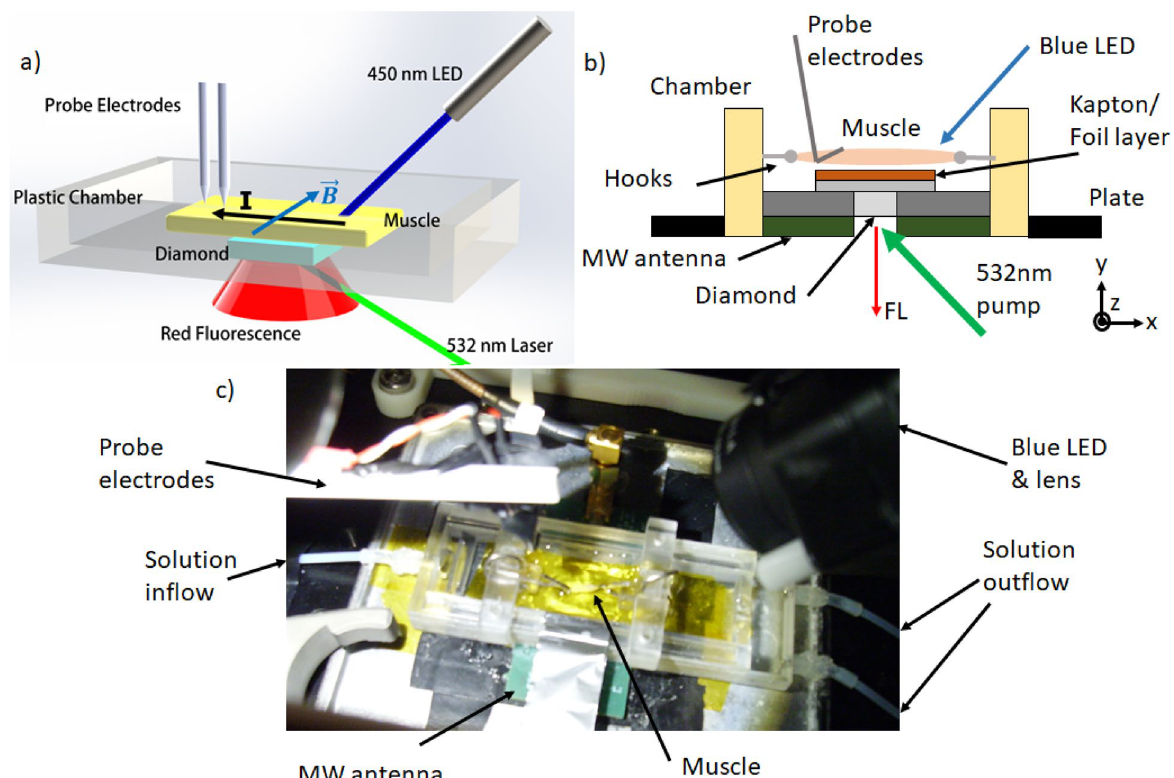
Figure 1. Experiment schematic and photograph. ( a ) Simplified 3D schematic of the magnetometer setup, showing the laser and blue LED illumination and fluorescence (FL) collection directions and sample chamber orientation, the direction of maximum magnetic field sensivity (B) and the direction of current flow (I) in the muscle. ( b ) Side view schematic (not to scale) of the chamber/diamond sensor/MW antenna stack, joined and affixed to a movable plate with silicone. ( c ) Photograph from above of the chamber, showing solution inflow connections and the mouse muscle, below which the diamond lies separated by a layer of Kapton tape and aluminium foil acting as a